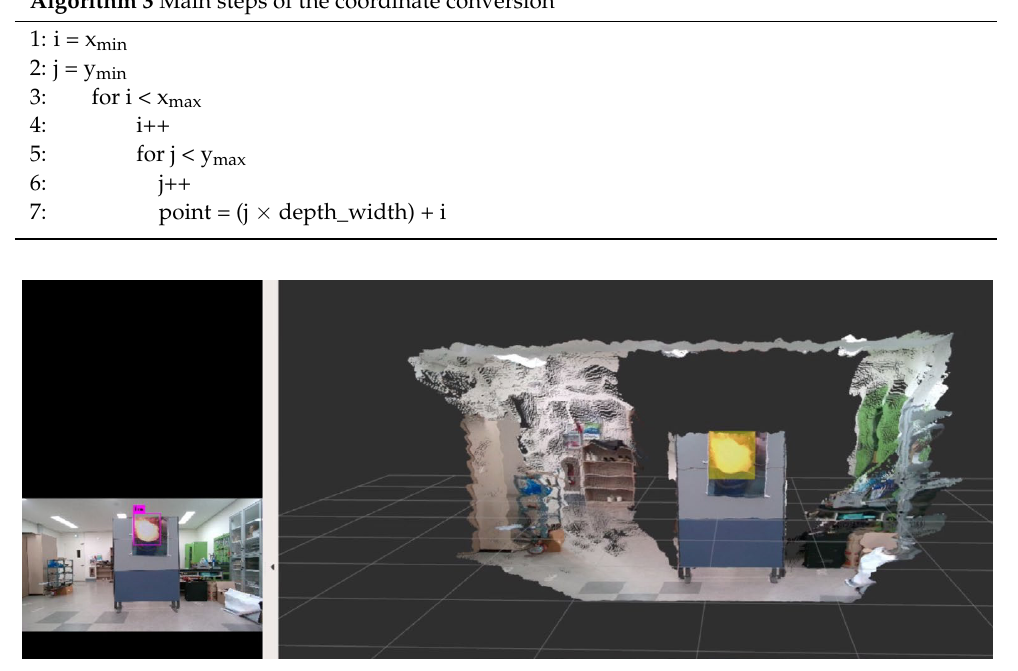
Figure 3. Coordinate conversion of RGB to RGBD. Purple square is a fire bounding box.